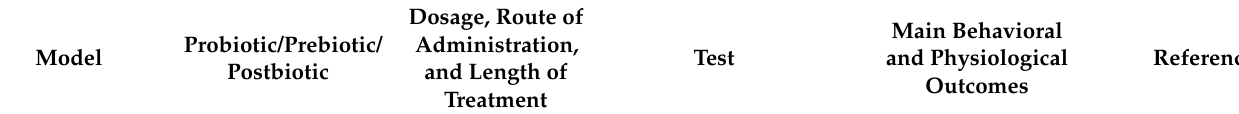
Table 2. Probiotics, prebiotics and postbiotics in animal studies on models of depression